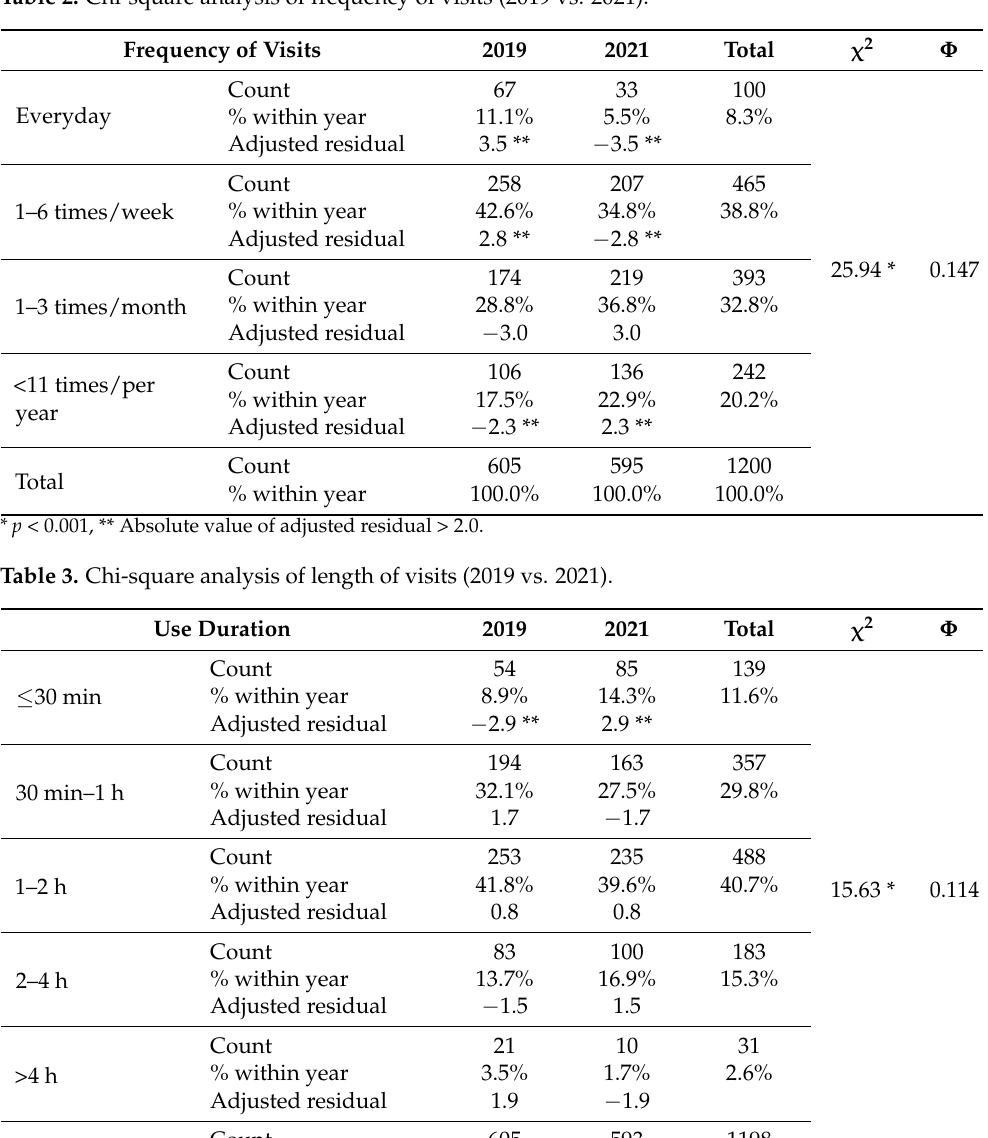
Table 2. Chi-square analysis of frequency of visits (2019 vs. 2021).